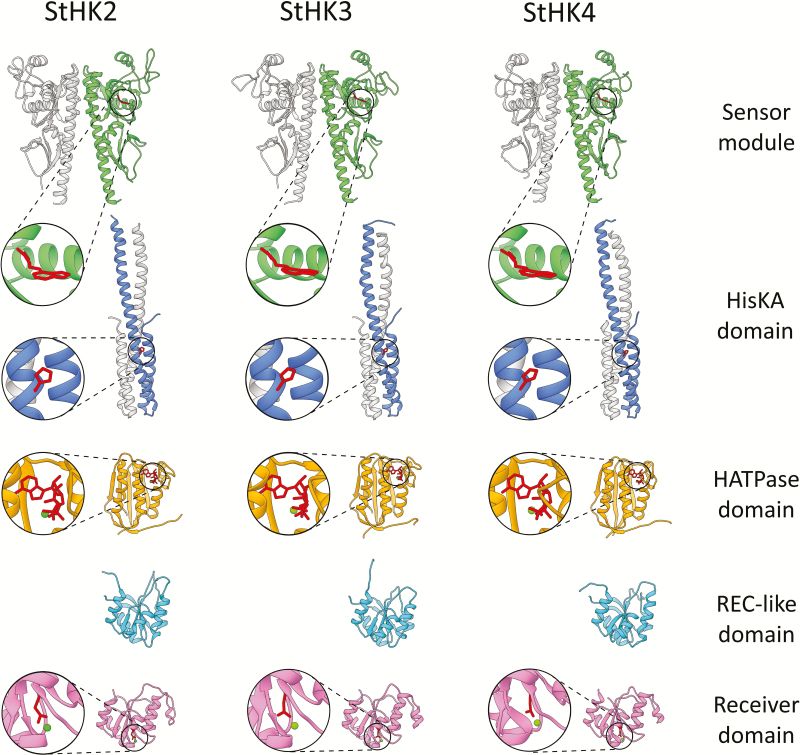
Homology models for predicted potato CK receptor domains. Sensor modules and HisKA domain are presented as dimers where one of subunits is colored grey. Positions of hormone, ATP and phosphoaccepting His/Asp residues are highlighted (red). Green spheres represent Mg2+ ions. For additional details, see Supplementary Tables S1 and S4.